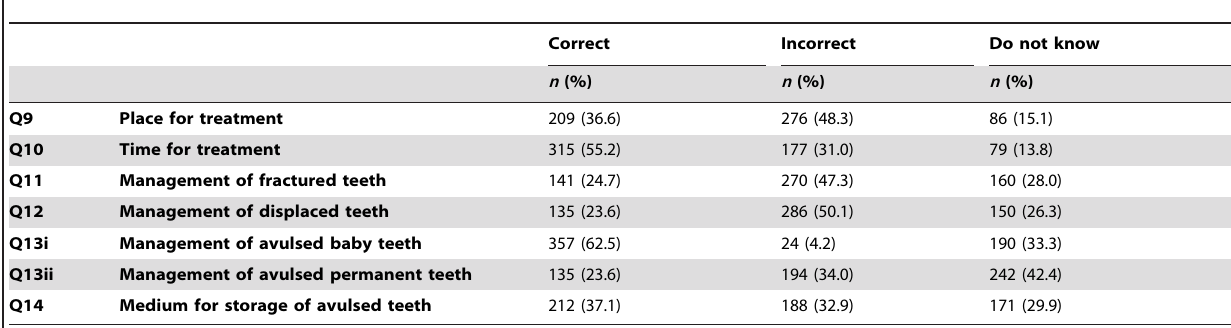
Table 4. Score for each question in the knowledge